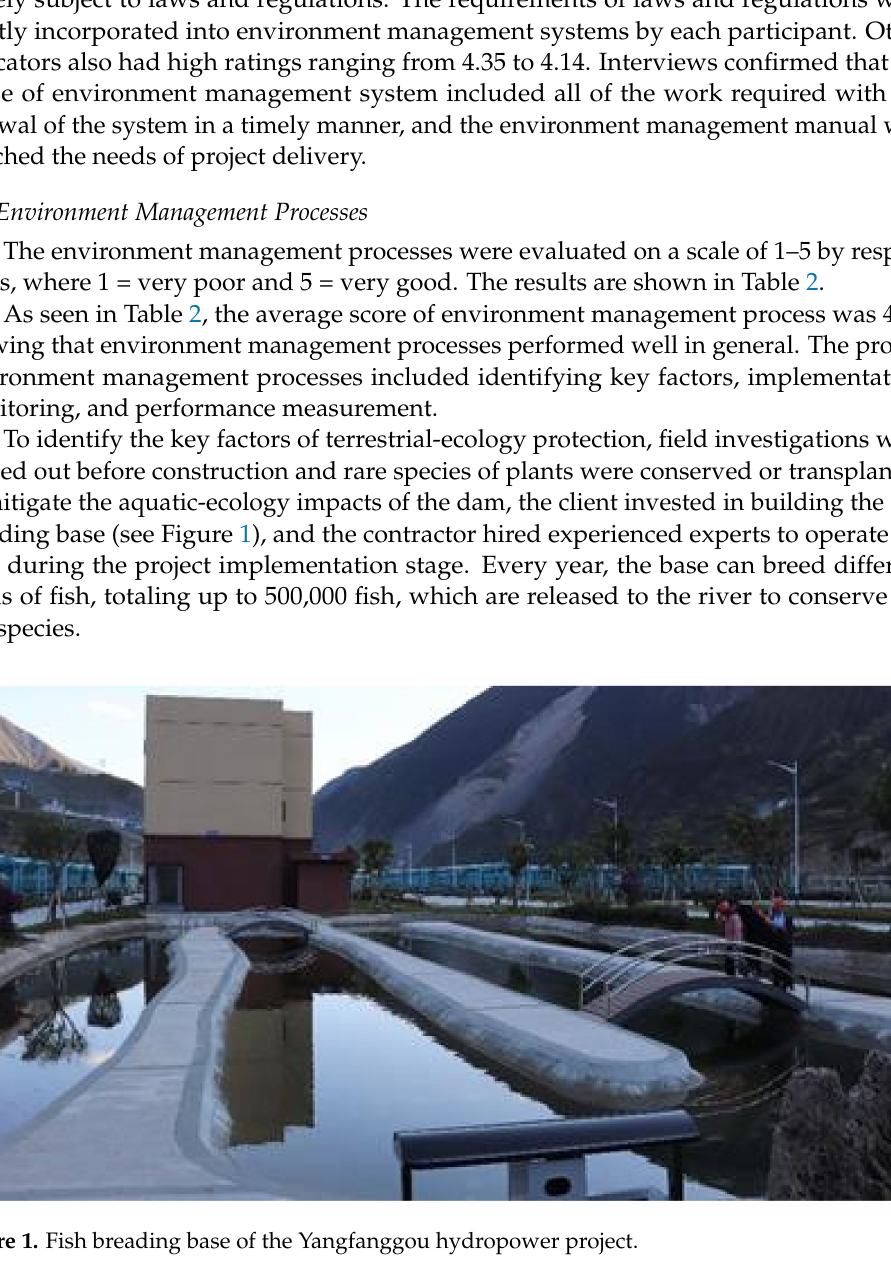
Figure 1. Fish breading base of the Yangfanggou hydropower